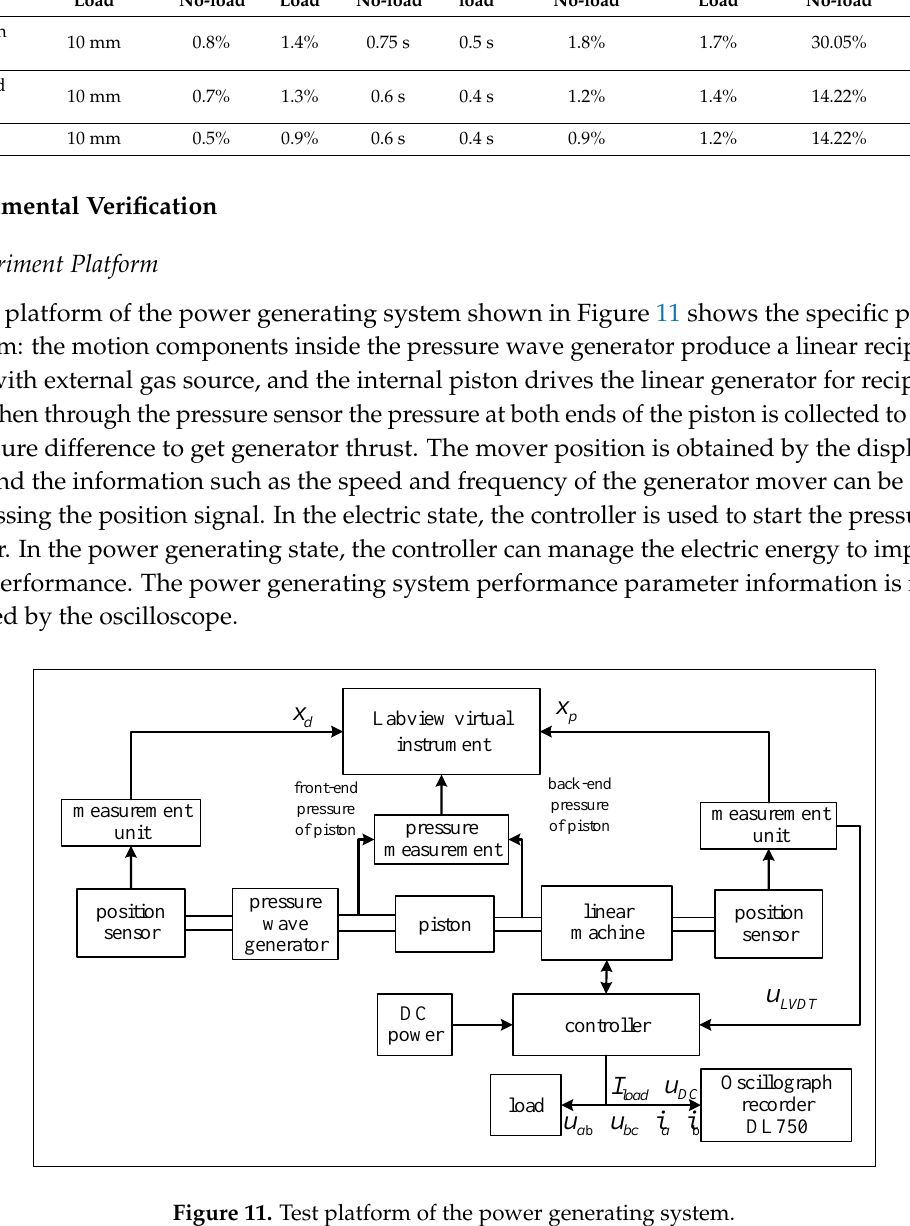
Figure 12. Photo of the controller. Figure 13. Test platform photo of power generating system. Structure parameters of linear machine are shown in Table 3.